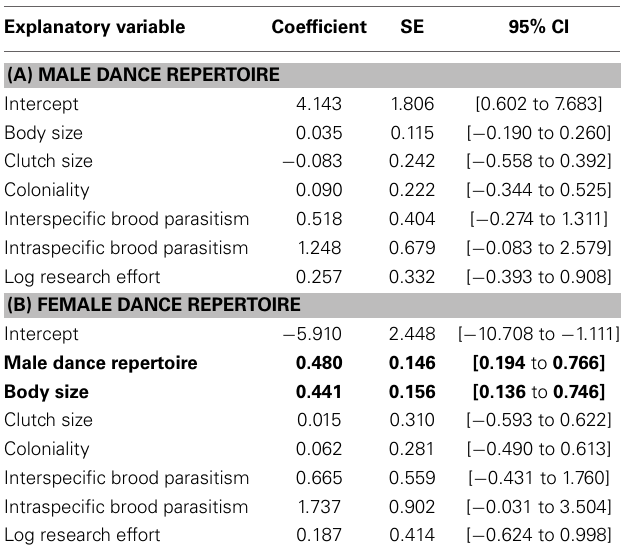
Table 2 | Effects of life-history traits on dance complexity in male (A) and female (B) Estrildid finches.